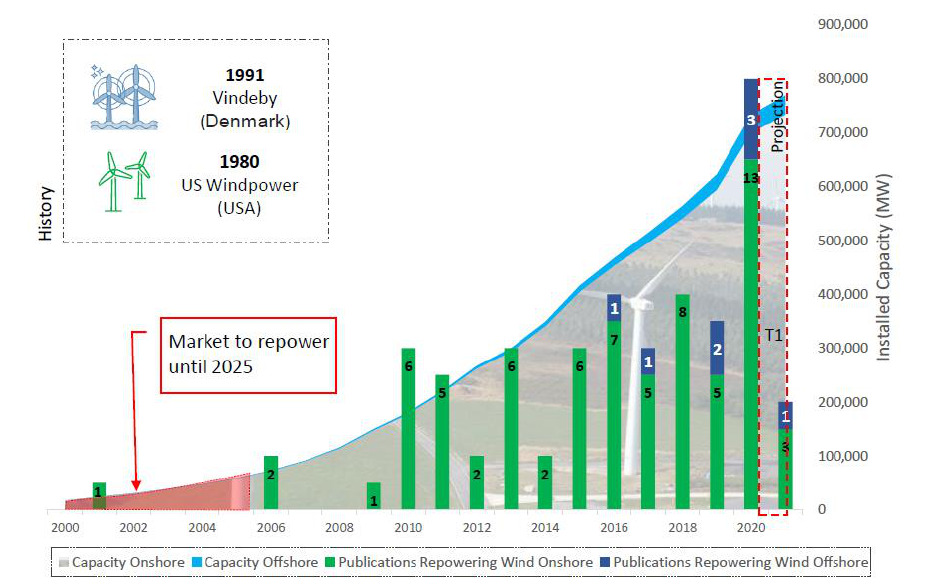
Figure 3. 2000–2021 Evolution of installed capacity vs. scientific publications (source: own elaboration).